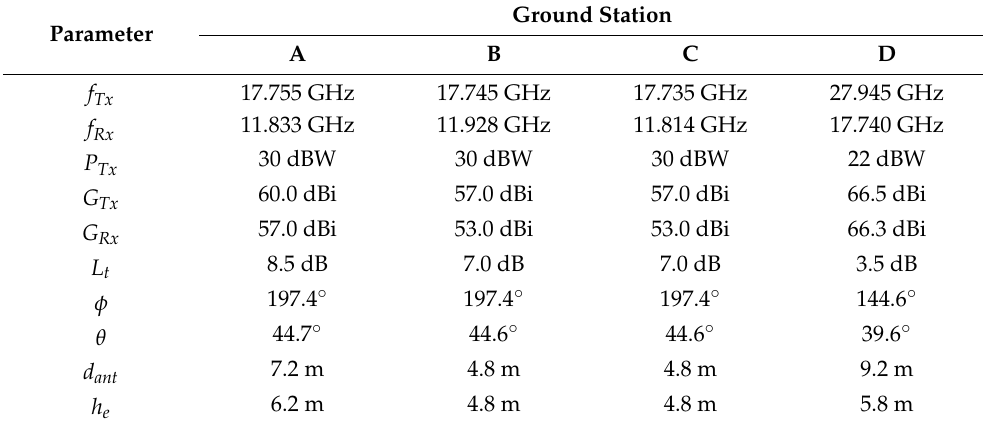
Table 1. Technical Parameters of the Ground Stations for the Interference Assessment. Parameter